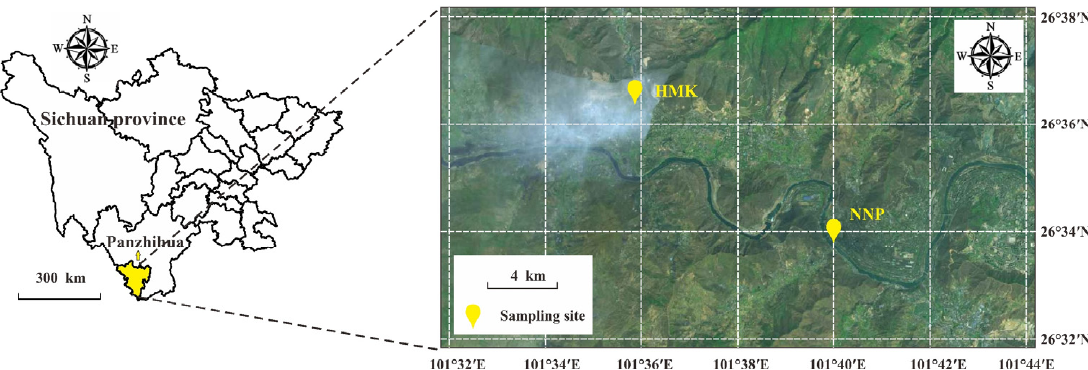
Figure 1. Location of sampling sites in Panzhihua.